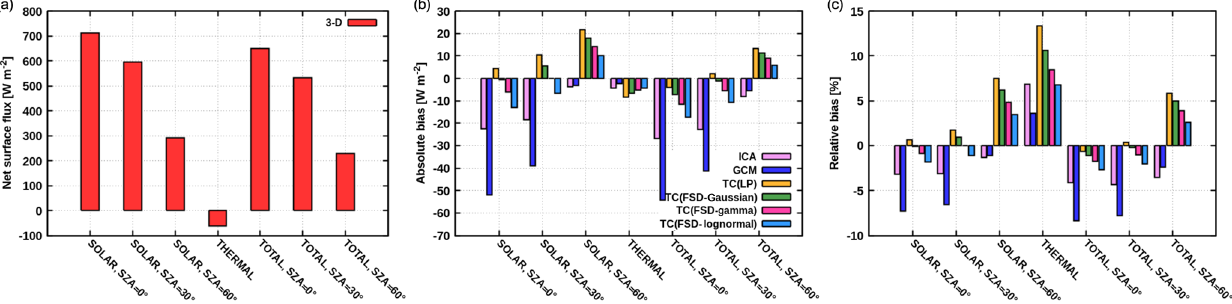
Figure 15. (a) benchmark net surface radiative flux. (b, c) bias for the ICA, GCM and TC